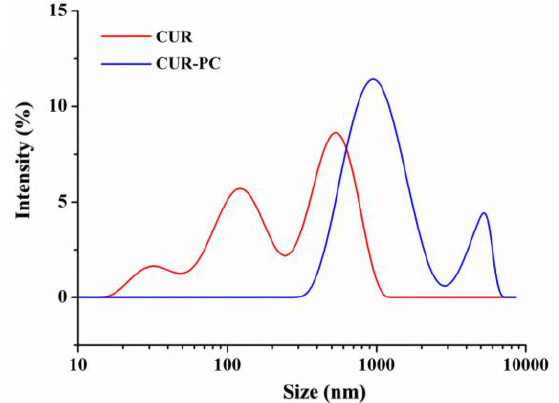
Figure 5. Particle size of renatured CUR and CUR-PC.